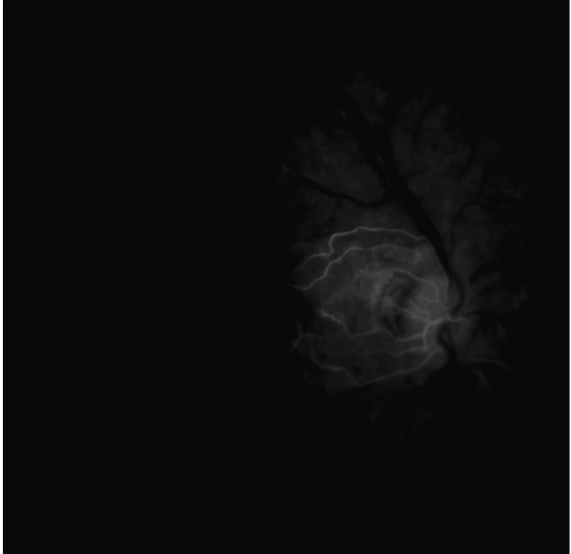
Figure 4: Postoperative retinal reperfusion of the right